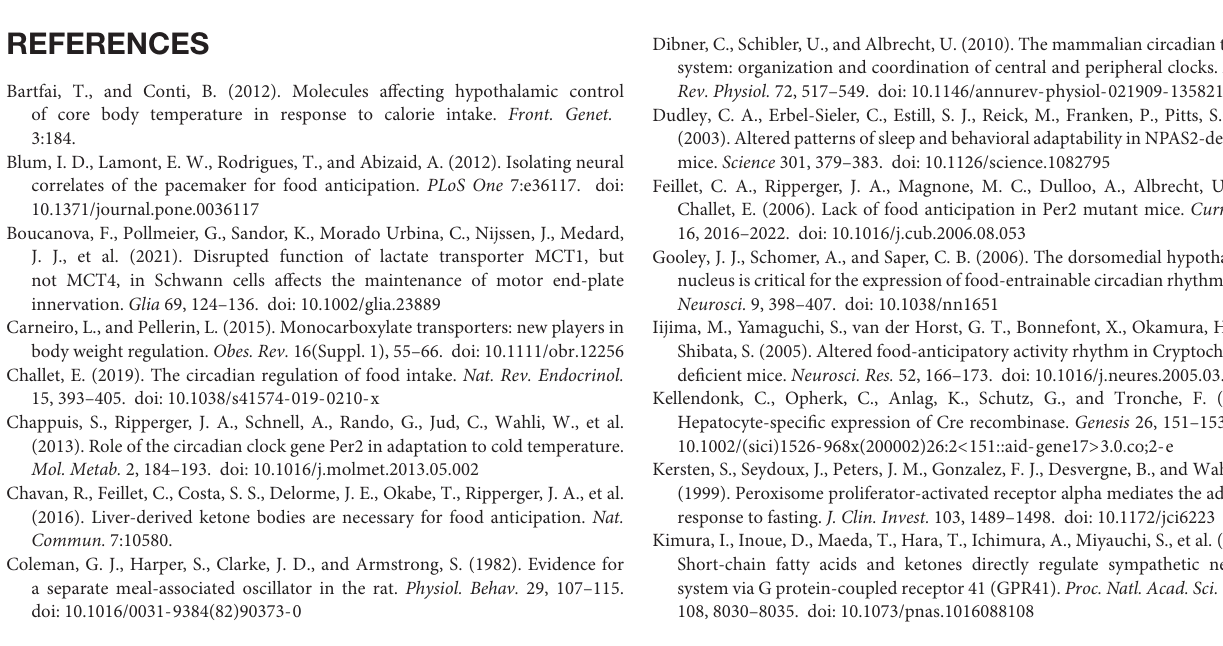
Supplementary Figure 4 | Generation of tissue-specific Mct1 KO mice. (A) Top panel: Diagram of the Mct1 wild-type allele ( Mct1 + / + ), conditional KO allele with LoxP sites flanking exon 5 ( Mct1 fl / fl ), and the constitutive KO ( Mct1 − / − ) allele after Cre recombination. Bottom panel: Genotyping results of the corresponding wild-type, heterozygous and homozygous Mct1 floxed mice. The band at 280 bp refers to the wild-type allele, and the band at 420 bp indicates the LoxP insertion. (B) Genotyping of LMct1 − / − , NMct1 − / − , and GMct1 − / − mice reveals a deleted allele at 437 bp in the liver tissue of the Alb1 - Cre + Mct1 fl / fl animal and an absence of deleted alleles in the ear biopsy (used for initial genotyping) and the hypothalamus (HYP). In the case of the Nes - Cre driver, the strongest recombined band is noticed in the HYP, but expectedly a weak band could also be detected in the ear and liver tissue. The Gfap - Cre driver shows higher specificity, with recombination detected in the HYP and a weak band in the ear biopsy. Supplementary Figure 5 | Examples of double-plotted wheel-running actograms of LMct1 + / + (left panel) and LMct1 − / − mice (right panel) under ad libitum (AL) and daytime-restricted feeding (RF) conditions. The vertical line at ZT4 indicates the time of food access. Supplementary Figure 6 | Activity profile of first week of RF for (A) neuronal, (B) glial, and (C) liver homozygous Mct1 KO mice vs. corresponding controls shows that neuronal and glial Mct1 KO mice show same patterns of adaptation to RF as their corresponding controls, whereas the adaptation of LMct1 − / − mice is already affected in the first week of RF. Supplementary Figure 7 | Identification of β OHB was done based on (A) retention time and (B) EI-MS fragments of an authentic standard. β OHB in our sample was eluted (C) at the expected retention time of 9.46 min and (D) showed fragments identical to those of the authentic standard. (E) Quantification was based on a 6-point calibration curve. Supplementary Table 1 | Quantifications of total wheel revolutions between ZT 2 and 4, as well as between ZT 12 and 24 for each group of animals. The quantification includes the time-points that limit the intervals of quantification (closed intervals). The group comparison of non-normalized and normalized data vs. the control group was performed with the 2-tailed Student’s t -test ( n = 4–15). Supplementary Table 2 | Results of statistical analysis of comparison of FAA ZT2-4 using 2-way